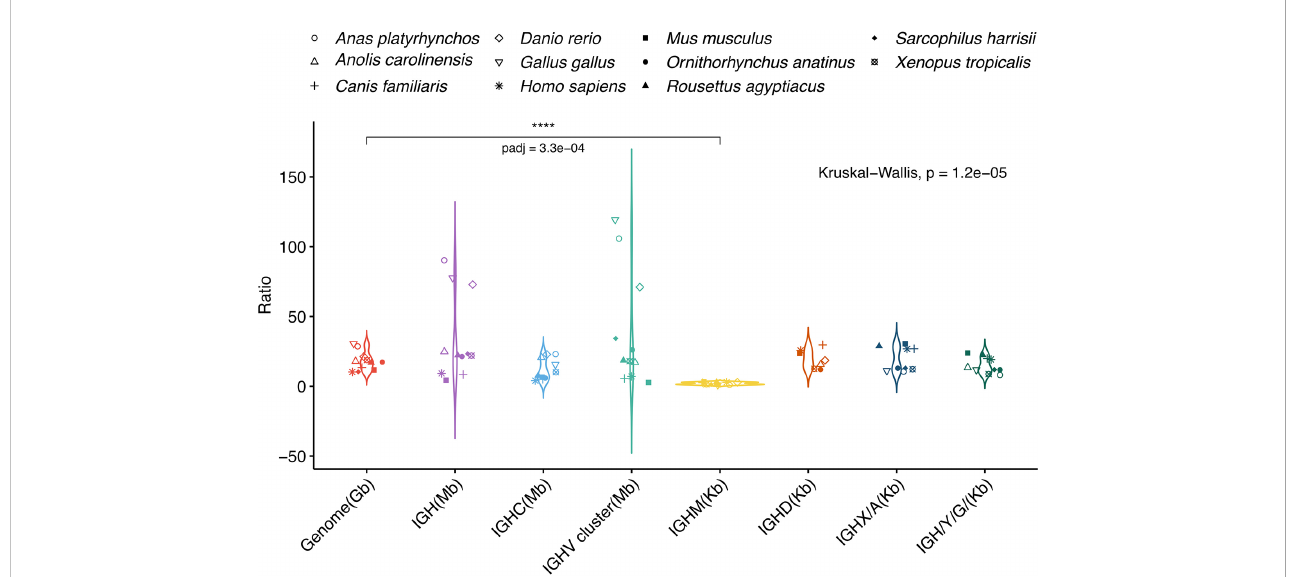
FIGURE 5 IGHM gene length in Ambystoma mexicanum is evolutionarily constrained. A. mexicanum genome (orange), IGH (purple), IGHC (light blue), IGHV cluster (light green) and individual IGHC gene length size ratios are plotted (from left to right). Comparisons include four placental mammals (human, mouse, dog and a bat), two non-placental mammals (Tasmanian devil and platypus), two bird species (chicken and duck), and one reptile, amphibian and teleost fi sh. Only the IGHM A. mexicanum : species size ratio was smaller to the respective genome size ratio (Kruskal-Walllis test, Dunnet multiple comparison correction (p =